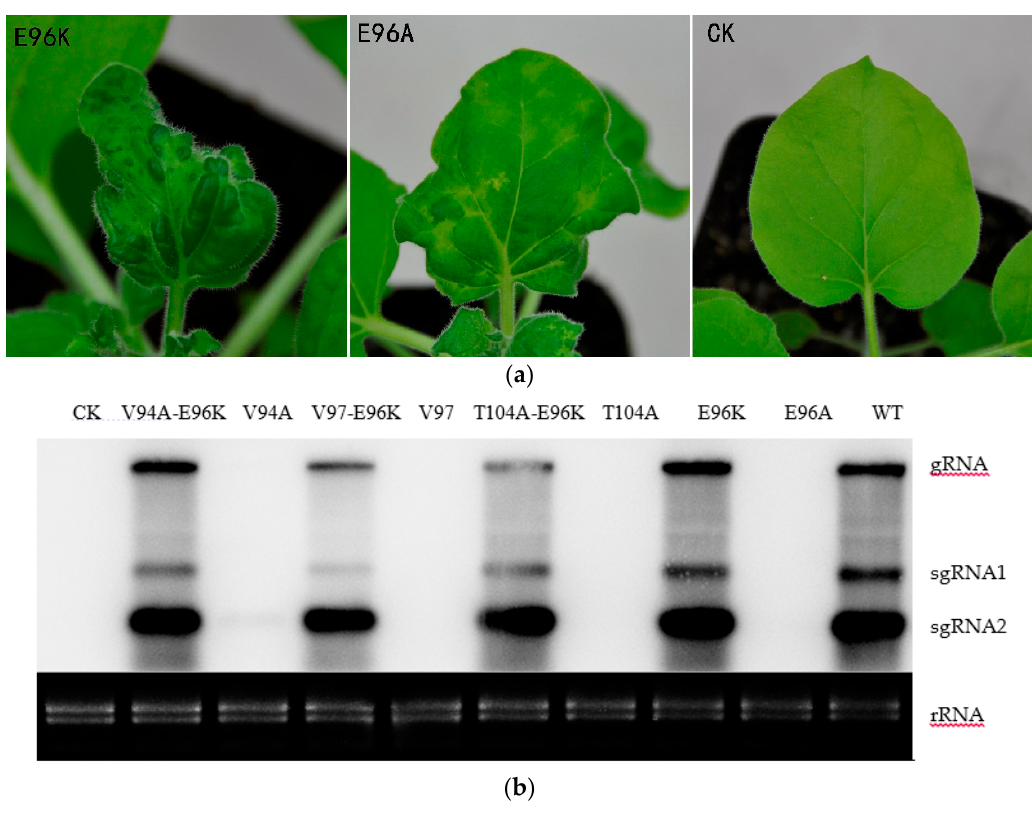
Figure 3. Northern blot analysis and the symptoms of single-site mutants in the E96 residue. ( a ) Symptoms of E96K and E96A at 10 and 14 dpi in tobacco, respectively; ( b ) Northern blot analysis of V94A-E96K, V94A, V97-E96K, V97, T104A-E96K, T104A, E96K, E96A, and the WT at 7 dpi. The positions of viral genomic RNA and the two subgenomic RNAs are displayed as gRNA, sgRNA1, and sgRNA2.